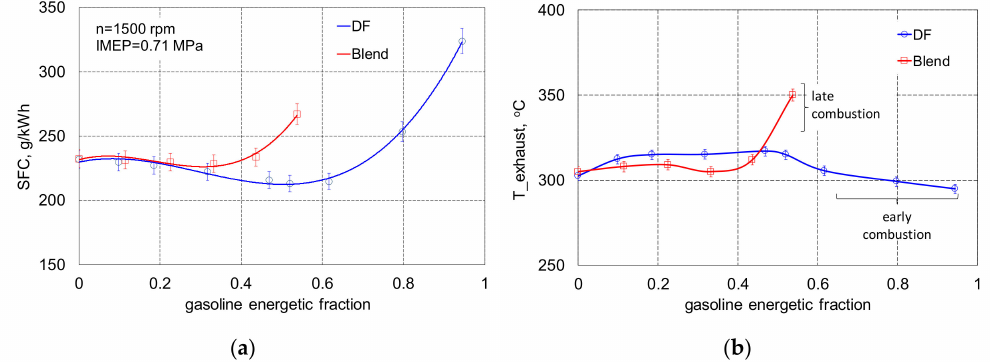
Figure 8. Specific fuel consumption (SFC) ( a ) and exhaust gases temperature (T_exh) ( b